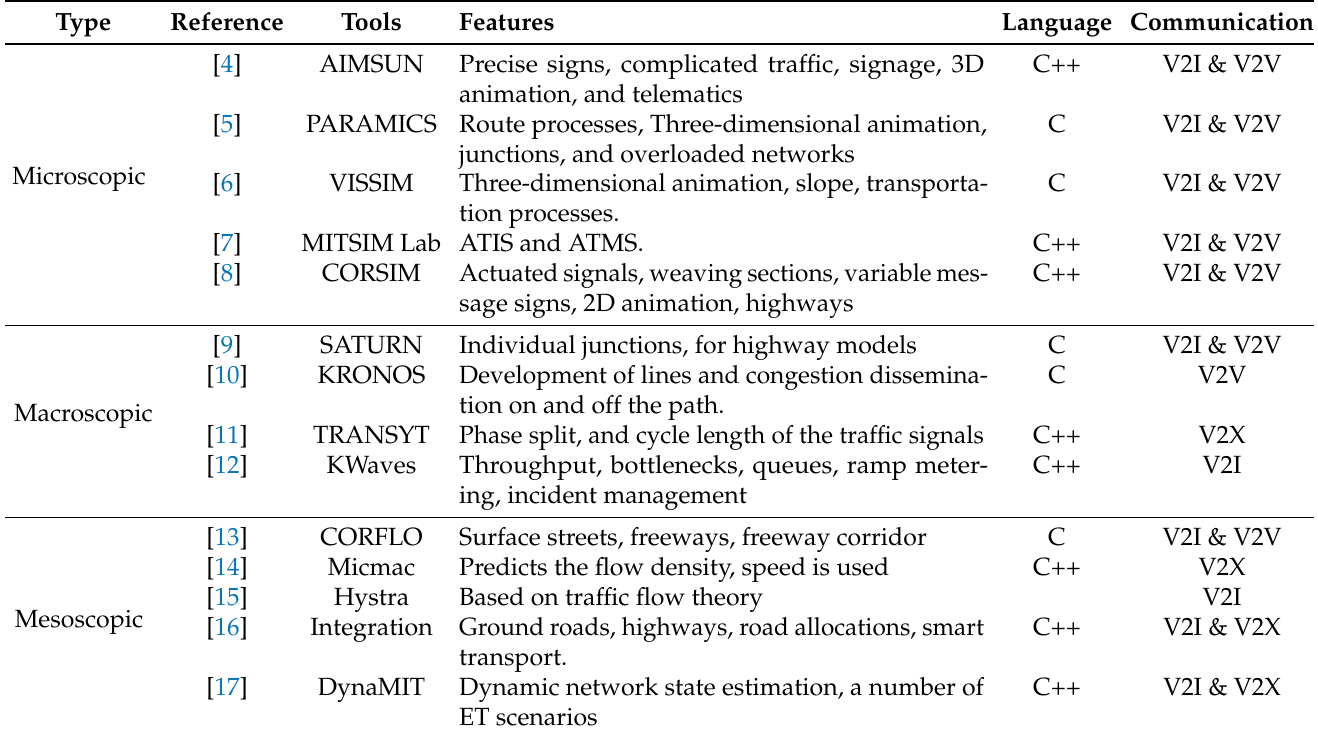
Table 1. Assessment of Simulation tools of TDE.